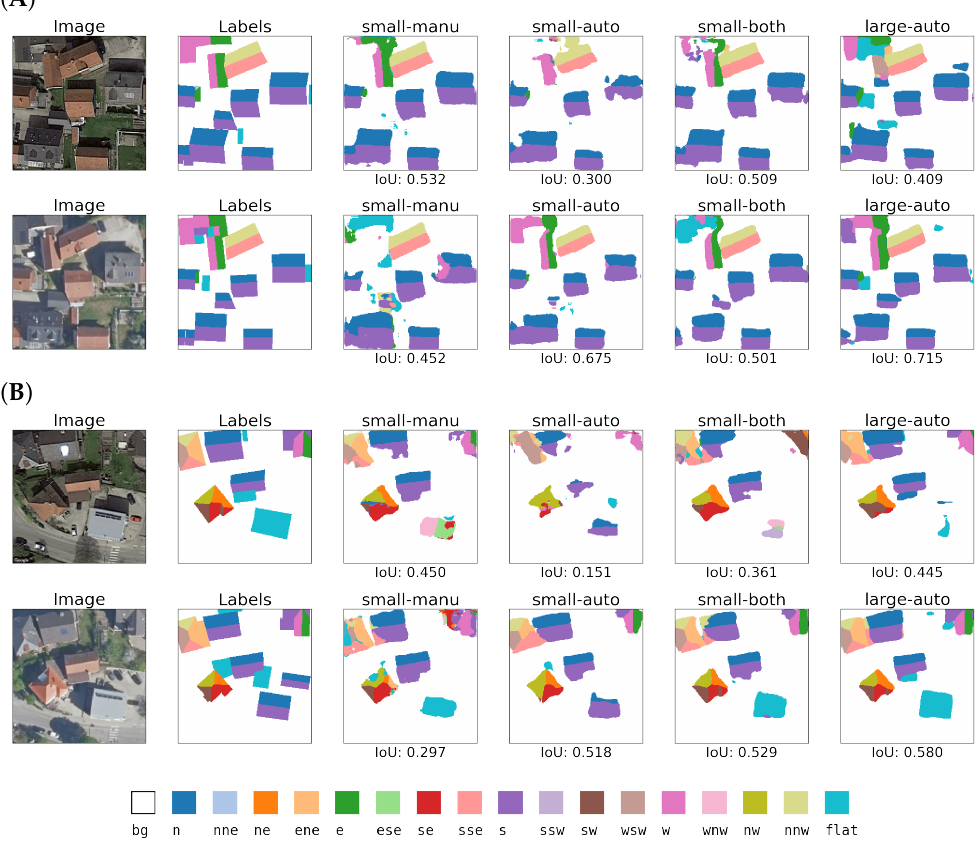
Figure 7. Test samples from the small-scale datasets small-manu and small-auto at two locations ( A , B ), and corresponding predictions from all models. For each location, the upper sample is from small-manu (Google image, manual labels) and the lower sample is from small-auto (LDBV image, auto labels). IoU with respect to labels is given for each